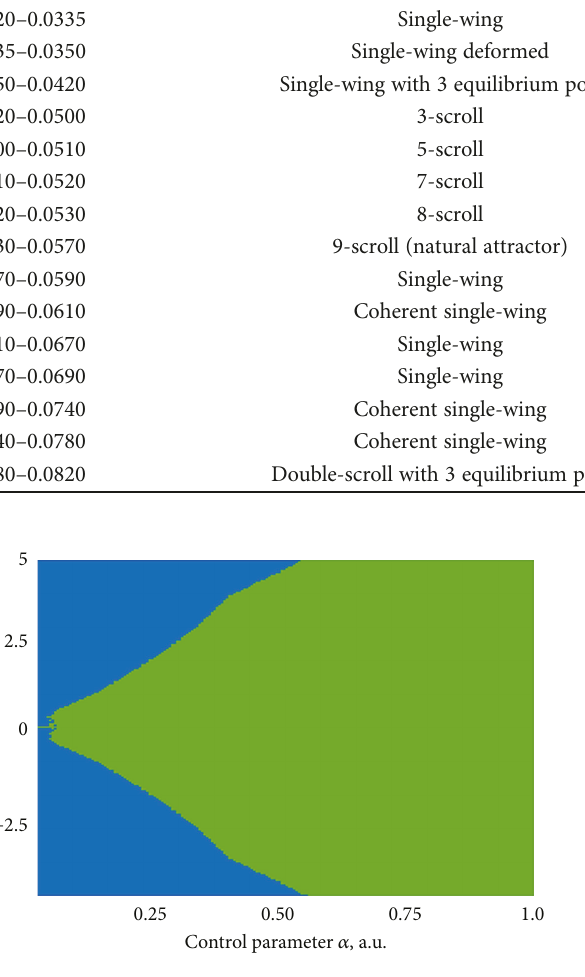
Figure 6: Bidimensional space α vs x system attractor by means of the dynamical parameter modi fi cation.